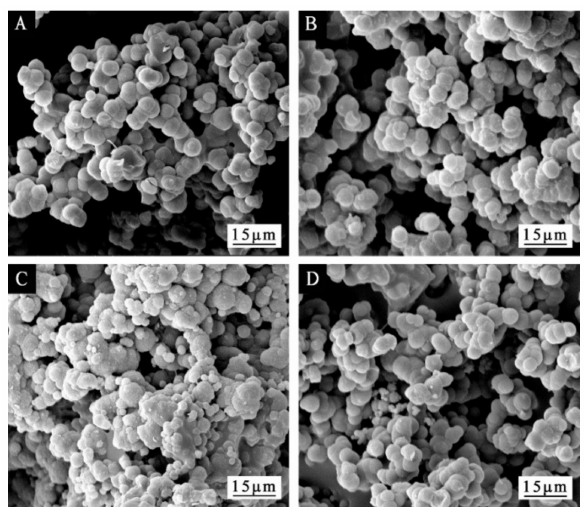
Figure 1. SEM of microcapsule with the core to wall mass ratio of ( A ) 0.83:1, ( B ) 0.75:1, ( C ) 0.67:1, and ( D ) 0.58:1.